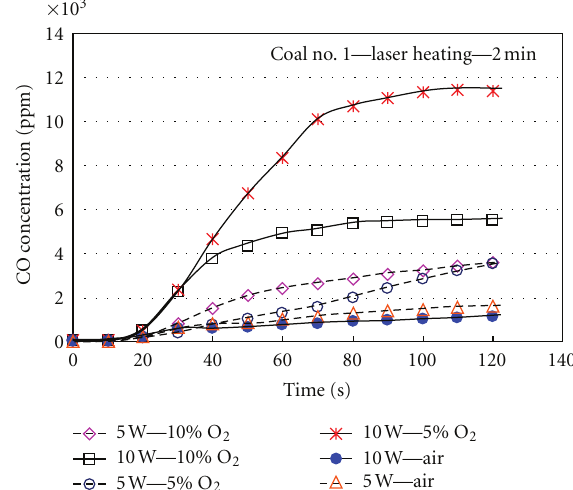
Figure 9: CO gas generated in CO 2 -rich and air